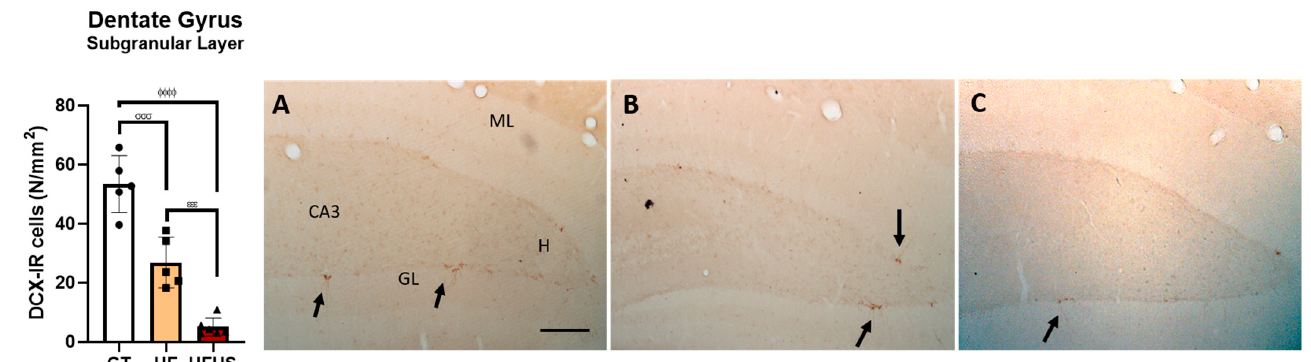
Figure 10. HFHS rats displayed decreased hippocampal neurogenesis. The histogram illustrates the mean ± SD of the total number of doublecortin (DCX)-IR neurons in the subgranular layer of the dentate gyrus. There was a significant reduction in the number of DCX-IR cells in HFHS animals compared to control and HF animals. ϕϕϕϕ p < 0.001 HFHS versus controls; σσσσ p < 0.001, HF versus control; εεεε p < 0.001 HFHS versus HF animals. The bar in white represent the mean for the control group, the bar in orange represent the mean for the HF group, and the bar in red represent the mean for the HFHS group. The circle represents the value for each animal in the control group, the square represents the value for each animal in the HF group, and the inverted triangle represents the value for each animal in the HFHS group. Illustrative photomicrographs of level-matched coronal sections of the dentate gyrus from control ( A ), HF ( B ), and HFHS ( C ) rats immunostained for doublecortin (DCX). Arrows show DCX-immunopositive cells in the dentate gyrus subgranular layer. ML, dentate gyrus molecular layer; GL, granule cell layer; H, dentate hilus; CA3, pyramidal cell layer of CA3 hippocampal field. Scale bar = 100 µm.